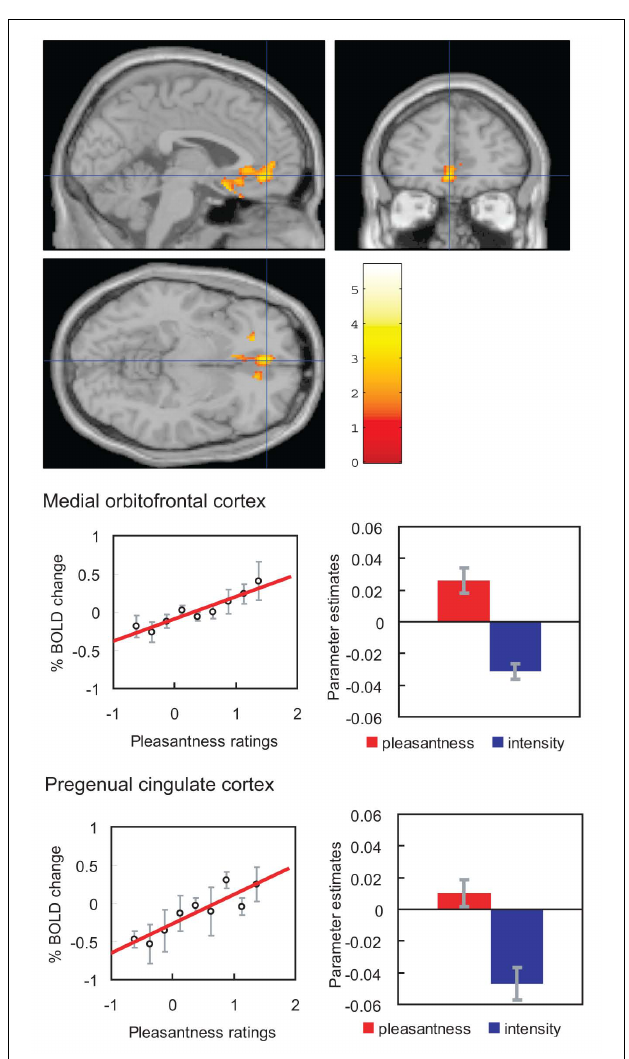
FIGURE 9 | Effect of paying attention to the pleasantness vs. the intensity of a taste stimulus. Top: a significant difference related to the taste period was found in the medial orbitofrontal cortex at [ − 6 14 − 20] z = 3.81 p < 0.003 (toward the back of the area of activation shown) and in the pregenual cingulate cortex at [ − 4 46 − 8] z = 2.90 p < 0.04 (at the cursor). Middle: medial orbitofrontal cortex. Right: the parameter estimates (mean ± SEM across subjects) for the activation at the specified coordinate for the conditions of paying attention to pleasantness or to intensity.The parameter estimates were significantly different for the orbitofrontal cortex t = 7.27, df = 11, p < 10 − 4 . Left: the correlation between the pleasantness ratings and the activation (% BOLD change) at the specified coordinate ( r = 0.94, df = 8, p (cid:3) 0.001). Bottom: pregenual cingulate cortex. Conventions as above. Right: the parameter estimates were significantly different for the pregenual cingulate cortex t = 8.70, df = 11, p < 10 − 5 . Left: the correlation between the pleasantness ratings and the activation (% BOLD change) at the specified coordinate ( r = 0.89, df = 8, p = 0.001).The taste stimulus, 0.1M monosodium glutamate, was identical on all trials. (After Grabenhorst and Rolls, 2008).